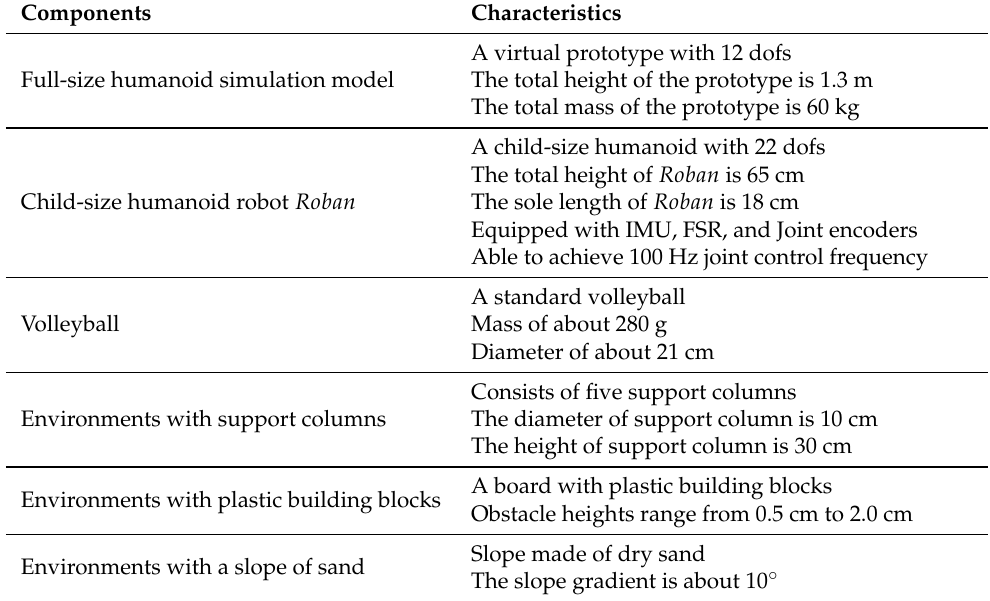
Table 2. Table for experiment setups.